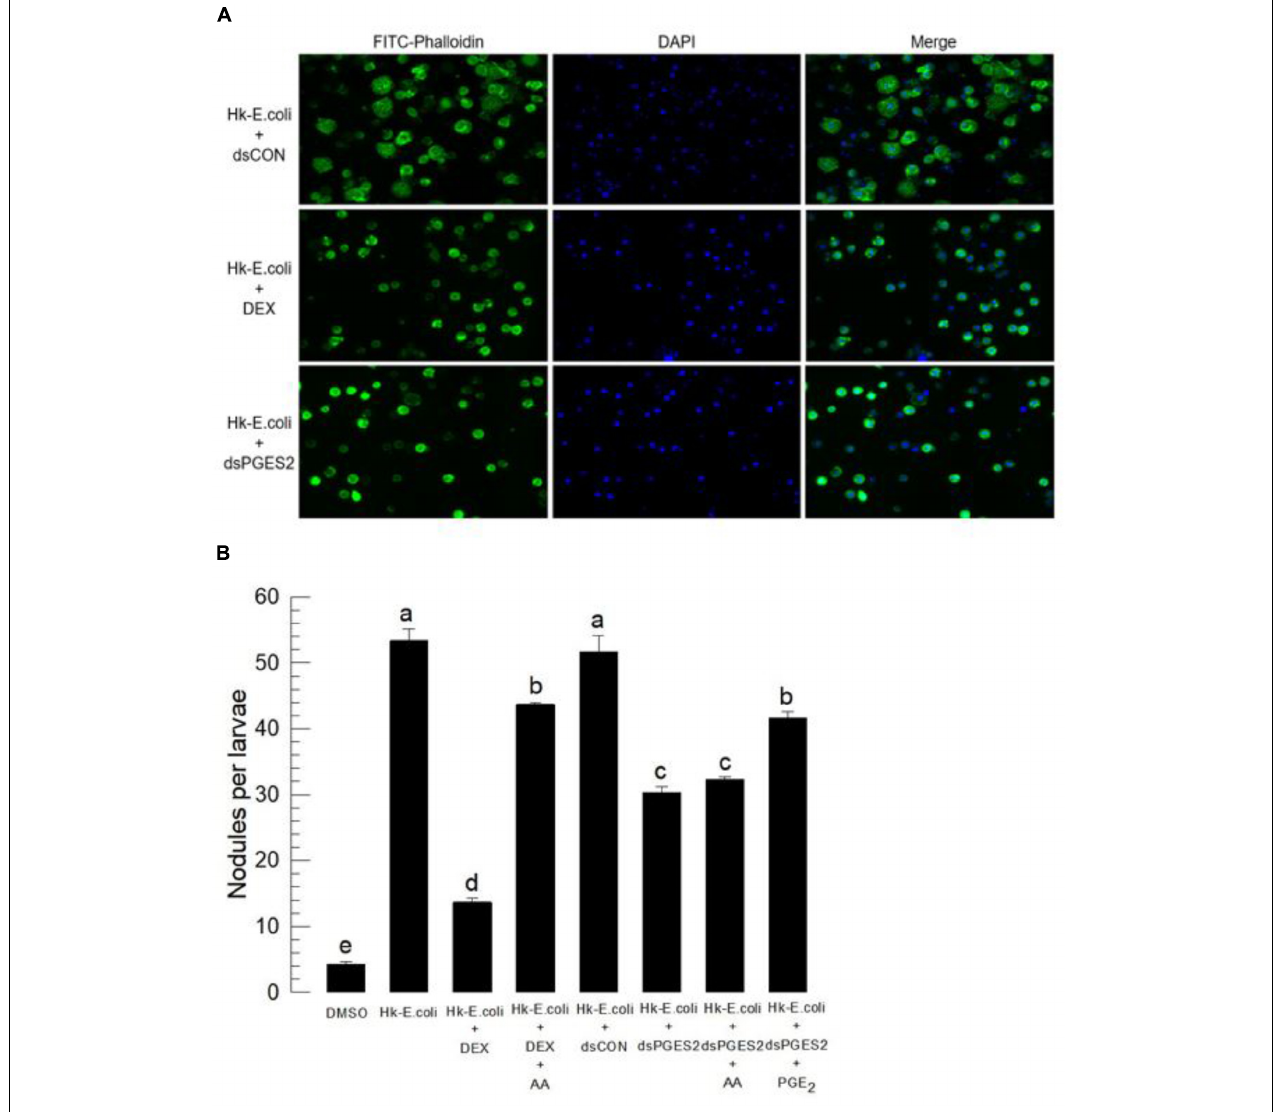
FIGURE 4 | Bioassay of a physiological role of Se-mPGES2 in cellular immunity after dsRNA treatments, performed as described in Figure 3 . For a bacterial challenge, heat-killed (HK) E. coli (5.4 × 10 4 cells per larva) was injected into larvae at 48 h after dsRNA treatment. (A) Inhibitory effect of dsSe-mPGES2 against F-actin growth in response to bacterial challenge. At 4 h PI, hemocytes were observed under a fluorescence microscope at 40 × magnification. Hemocytic F-actin filaments were specifically recognized by FITC-tagged phalloidin (green) while nucleus was stained with DAPI (blue). A PLA 2 inhibitor, dexamethasone (“DEX”), was used along with bacteria. (B) Inhibitory effect of dsSe-mPGES2 against hemocyte nodule formation in response to the bacterial challenge. At 8 h PI, numbers of nodules were assessed. Each treatment was independently replicated five times. Different letters indicate significant differences among means at Type I error = 0.05 (LSD